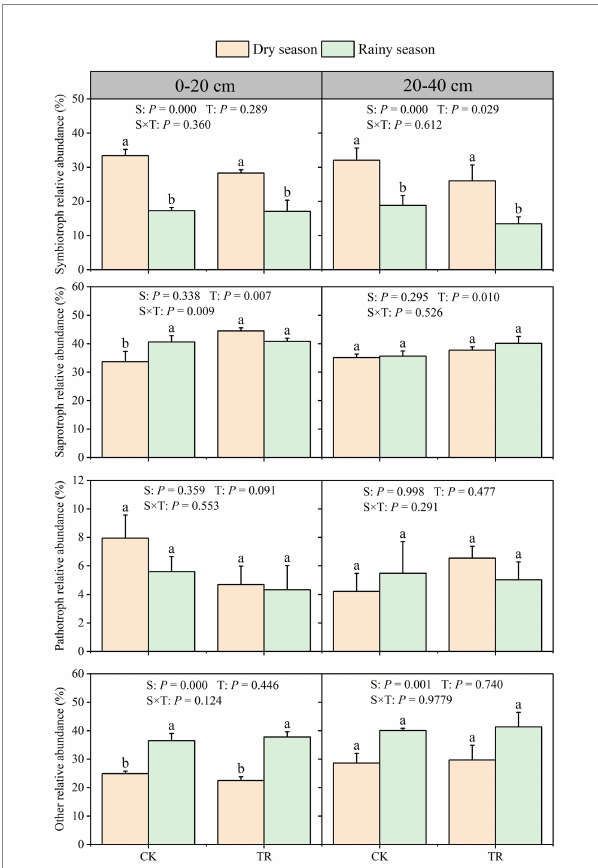
FIGURE 8 Nutritional mode of soil fungal community. Data are expressed as means + standard error ( n = 3). Statistically significant differences ( p < 0.05) between treatments are indicated by lowercase letters based on the Kruskal-Wallis test. CK: control; TR: throughfall reduction treatment. p -values from GLM analyzes are indicated at the top of each graph; S, season, including dry season and rainy season; T, treatment, including TR and CK; S × T, the interaction of season and